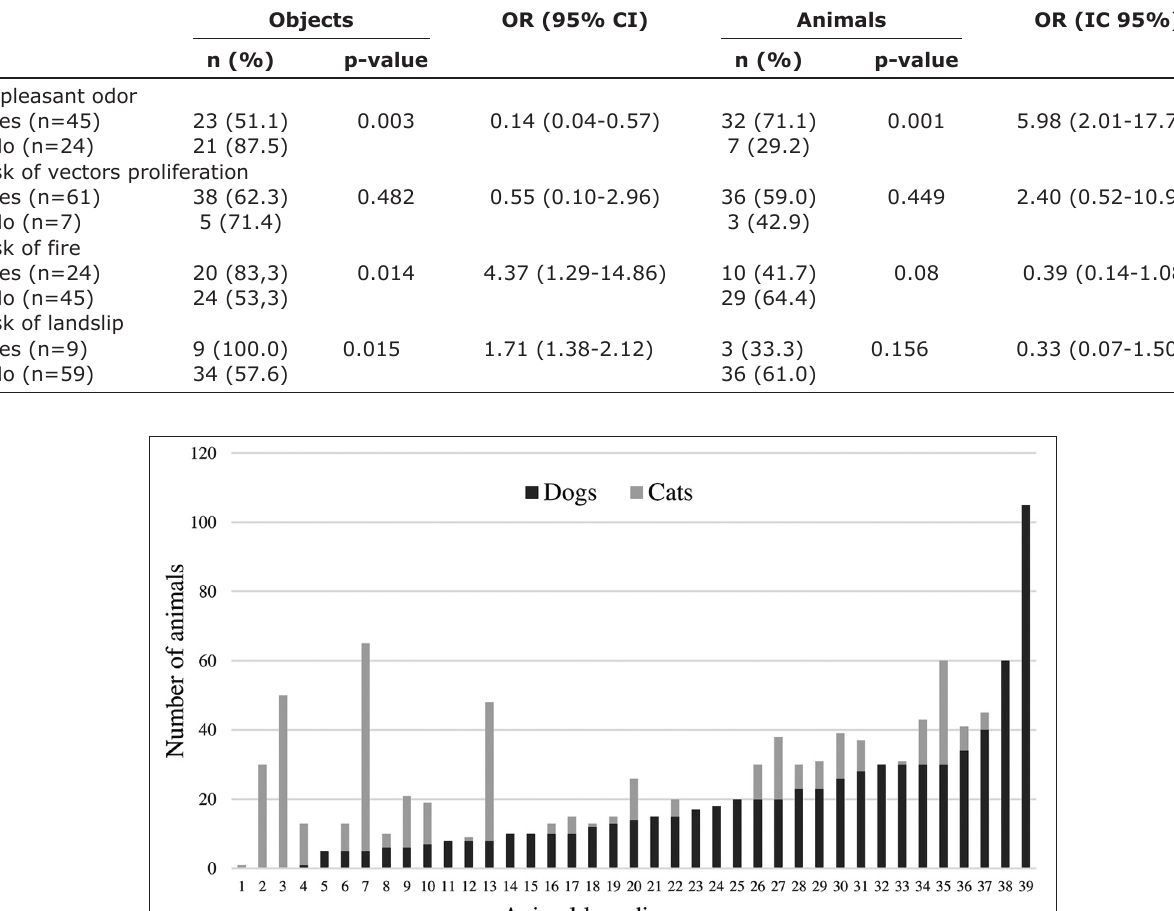
Table-2: Environmental factors associated with hoarding cases per type of accumulation in Curitiba, Brazil, from 2013 to